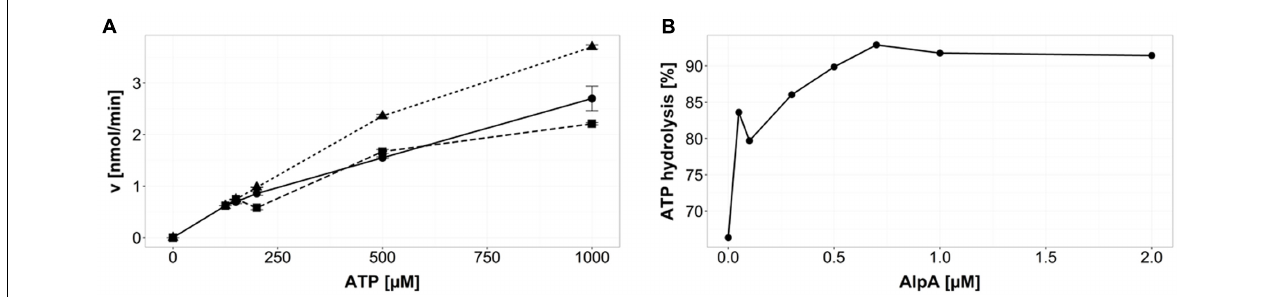
FIGURE 1 | AlpA influences AlpC nucleotide hydrolysis. (A) ATP hydrolysis of AlpC (1 µ M) is increased by free AlpA. ATP hydrolysis of GFP-AlpC (solid line with filled spheres) is shown with increasing ATP concentrations. Addition of 1 µ M mCherry-AlpA accelerates ATP hydrolysis of AlpC (dotted line with filled triangles). Addition of AlpA that was pre-incubated with alpS DNA reduces ATP turnover (broken line with filled squares. Error bars are showing SEM. (B) Equimolar concentrations of AlpA accelerate AlpC ATP hydrolysis. ATP hydrolysis of 1 µ M GFP-AlpC was measured. Addition of increasing concentrations of mCherry-AlpA stimulates nucleotide turnover until saturation is reached at about equimolar concentrations of AlpC and AlpA. Note that GFP-AlpC has about 60% of its maximal activity in absence of